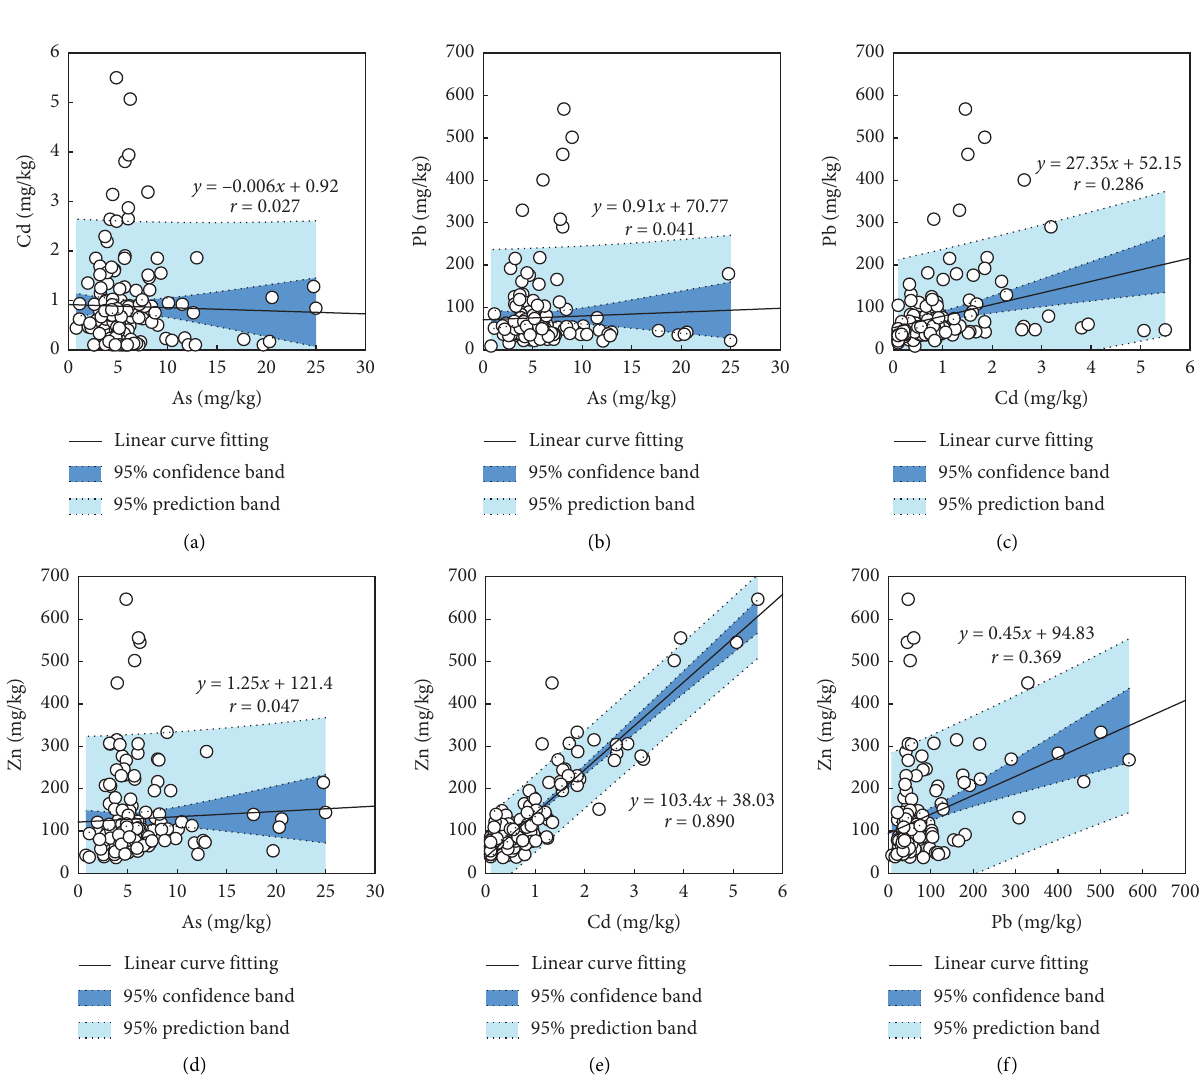
Figure 4: Relationships between (a) As and Cd, (b) As and Pb, (c) Cd and Pb, (d) As and Zn, (e) Cd and Zn, and (f) Pb and Zn concentrations in the agricultural soils ( n � 162) of the study